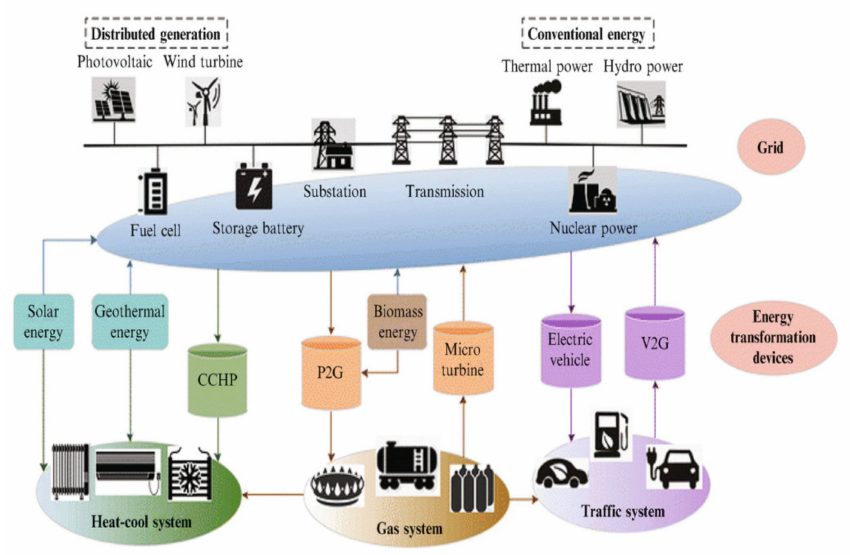
Figure 3. Sustainable Energy and IoT at Tourism Destinations (https://link.springer.com/chapter/ 10.1007/978-3-030-35291-2_6) (12 February